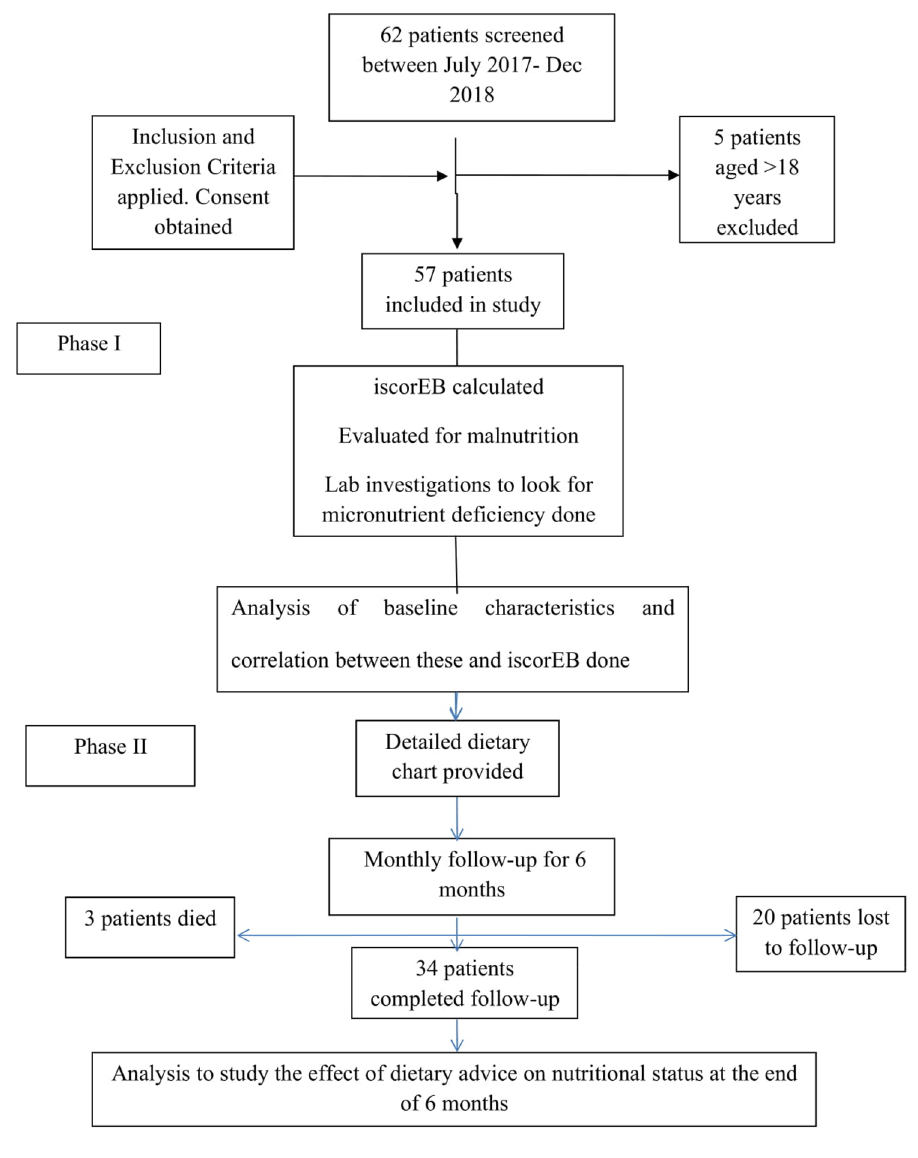
Figure 1. Flow Diagram of the